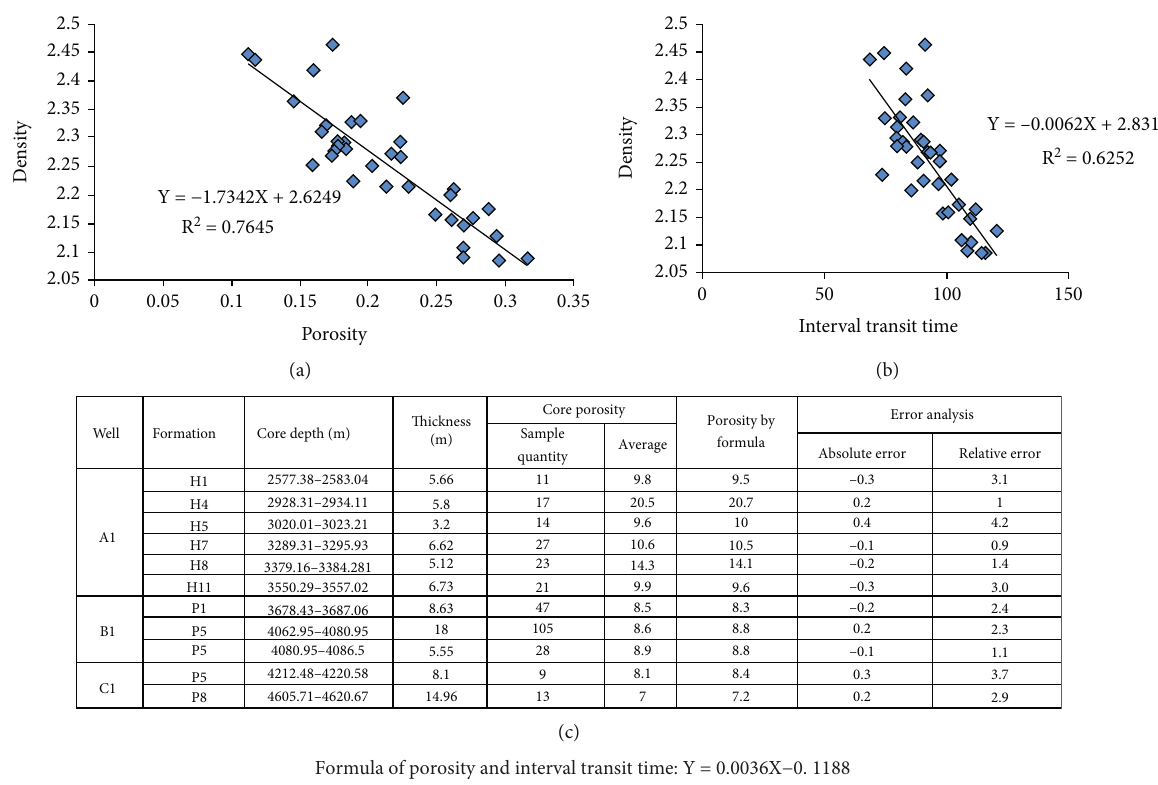
Figure 2: Correlation and error comparison between porosity and interval transit time of Well B4: (a) the relationship of B4 Well between porosity and density; (b) the relationship of B4 Well between interval transit time and density; (c) correlation and error comparison of 3 random wells; (d) the equation of porosity and interval transit time obtained by combining two formulas (a) and